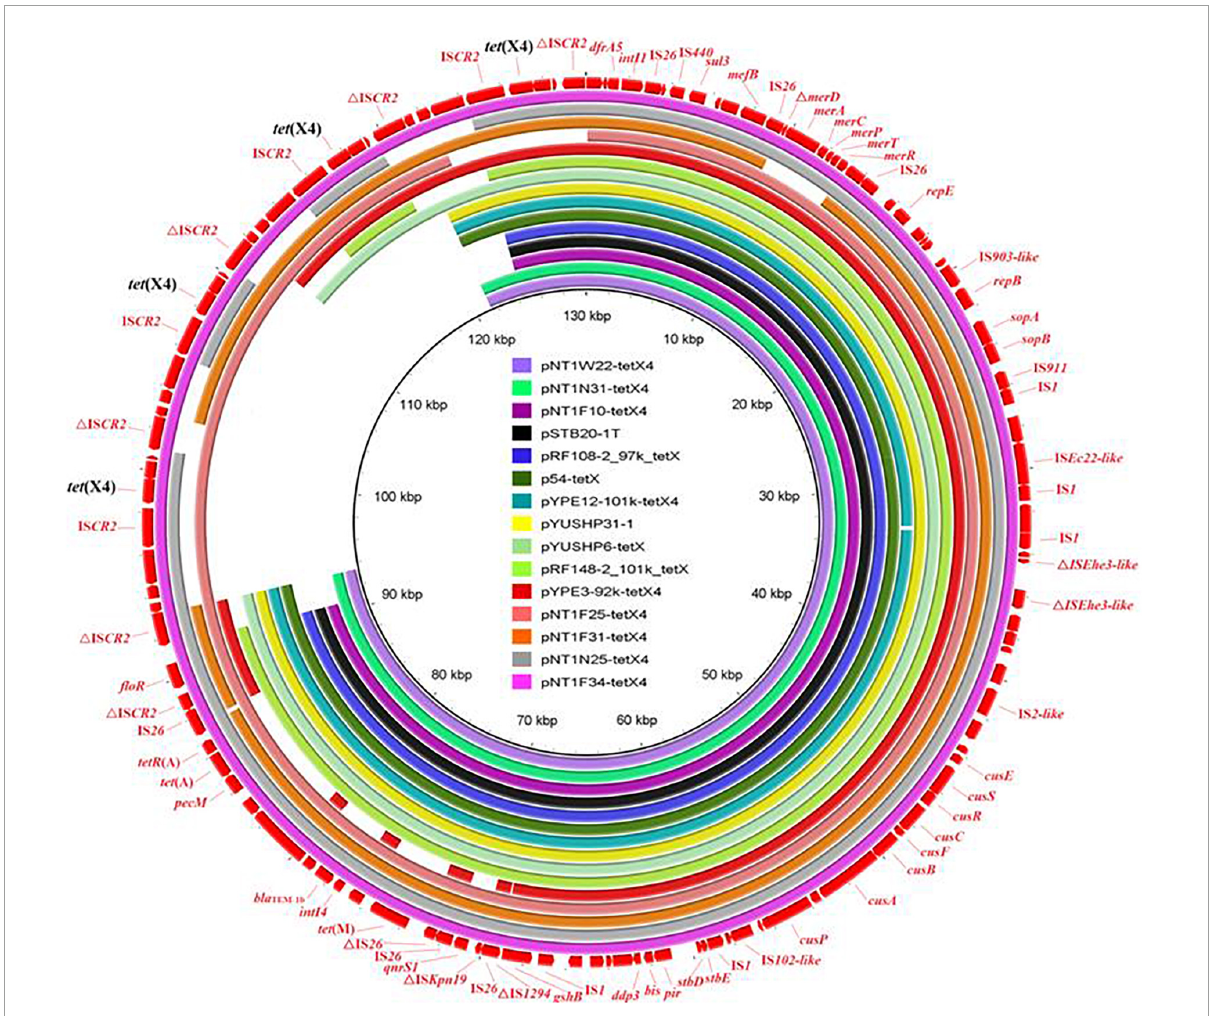
FIGURE2 Sequence comparison of tet (X4)-carrying plasmid pYUSHP31-1 from E. coli isolate SH21PTE31 in this study with other similar IncFIA18/IncFIB(K)/IncX1 plasmids using BRIG. The reference sequence pNT1F34-tetX (CP075486) is indicated in red in the outer